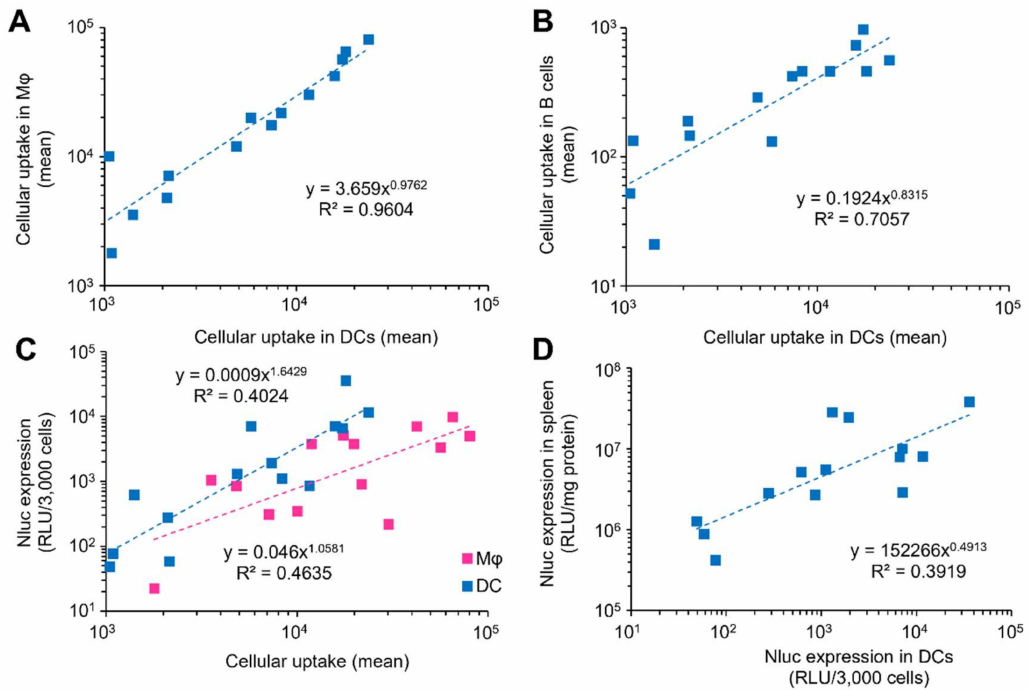
Figure 2. Correlations between outputs of in vivo experiments in screening A. ( A ) A dot-plot of cellular uptake in M ϕ versus that in DCs. ( B ) A dot-plot of cellular uptake in B cells versus that in DCs. ( C ) A dot-plot of Nluc expression versus cellular uptake in both M ϕ and DCs. ( D ) A dot-plot of Nluc expression in spleen versus in